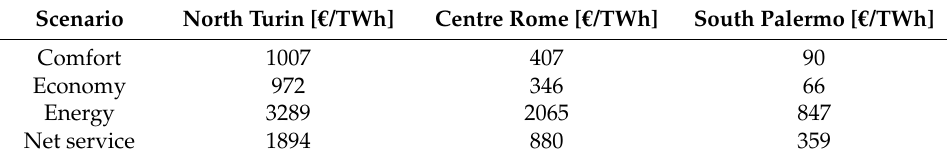
Table 11. Economic saving due to the reduction of the energy losses in the grid (presence of PV).